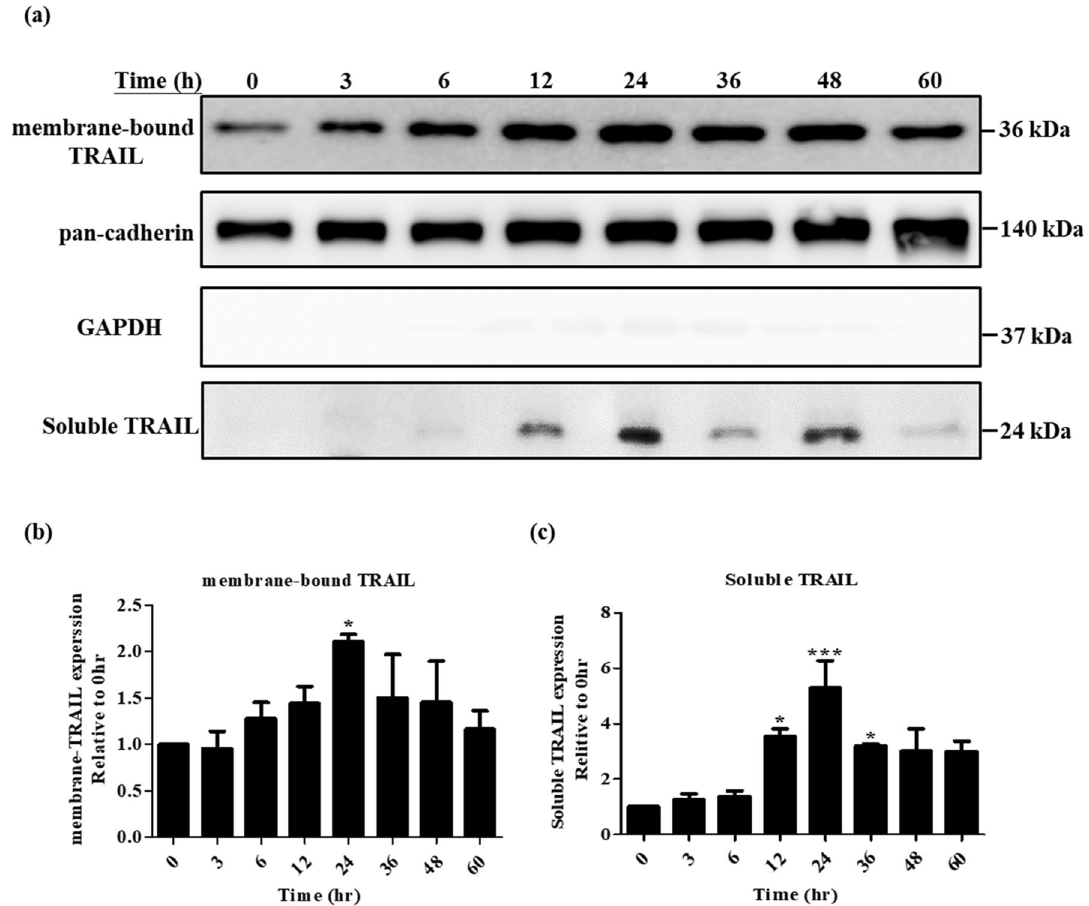
Figure 4. IL-1β induced the membrane-bound TRAIL protein and soluble TRAIL expression in hUCMSCs. ( a ) Time course of the membrane-bound TRAIL protein expression in hUCMSCs with 100 ng/ml IL-1β treatment analyzed by Western blot. ( b ) Quantitative graphs of membrane-bound TRAIL protein expression of ( a ). ( c ) Quantitative graphs of soluble TRAIL protein expression of (a). The gray analysis of Western blots of membrane-bound TRAIL was normalized with pan-cadherin. The full-length Western blots were shown in Supplementary Fig. S3. Data were shown as mean ± SEM and analyzed by one-way ANOVA with Dunnett’s test. (n = 3, * P < 0.05, *** P <